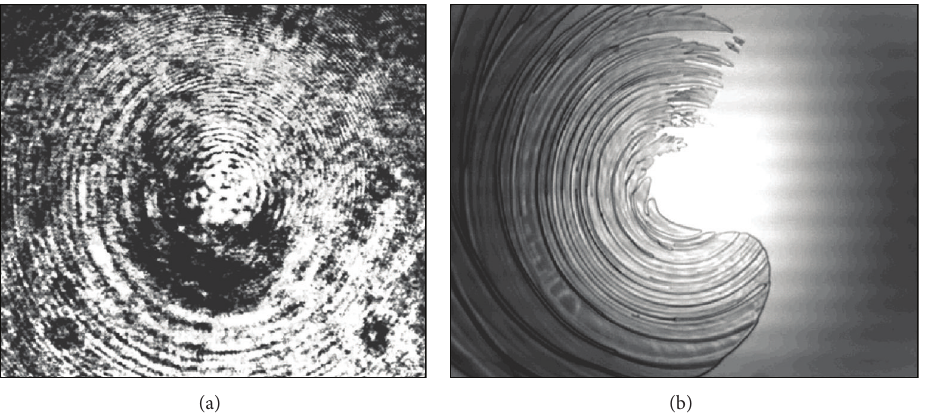
Figure 14: Periodic stress distribution (a) and morphological picture (b) of the rotational deformation of a polybutene sample at a high deformation